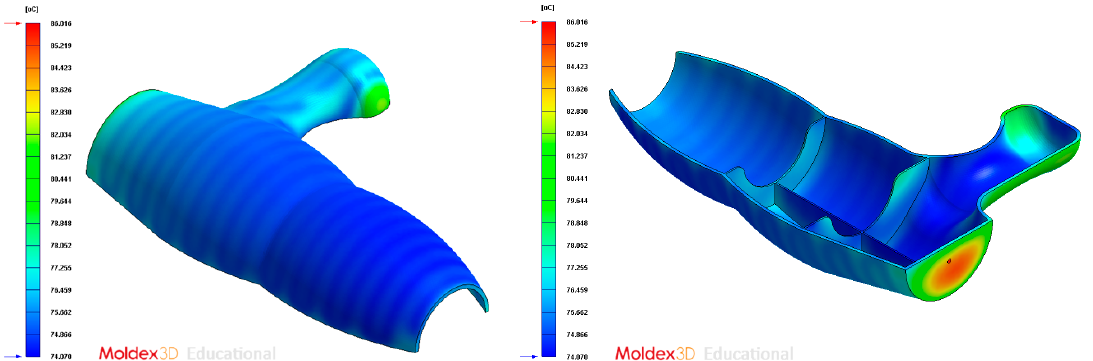
Figure 24. Average temperature (°C) on the surface of the plastic part after the cooling phase, Case B. Front view ( left ) and bottom view ( right ).